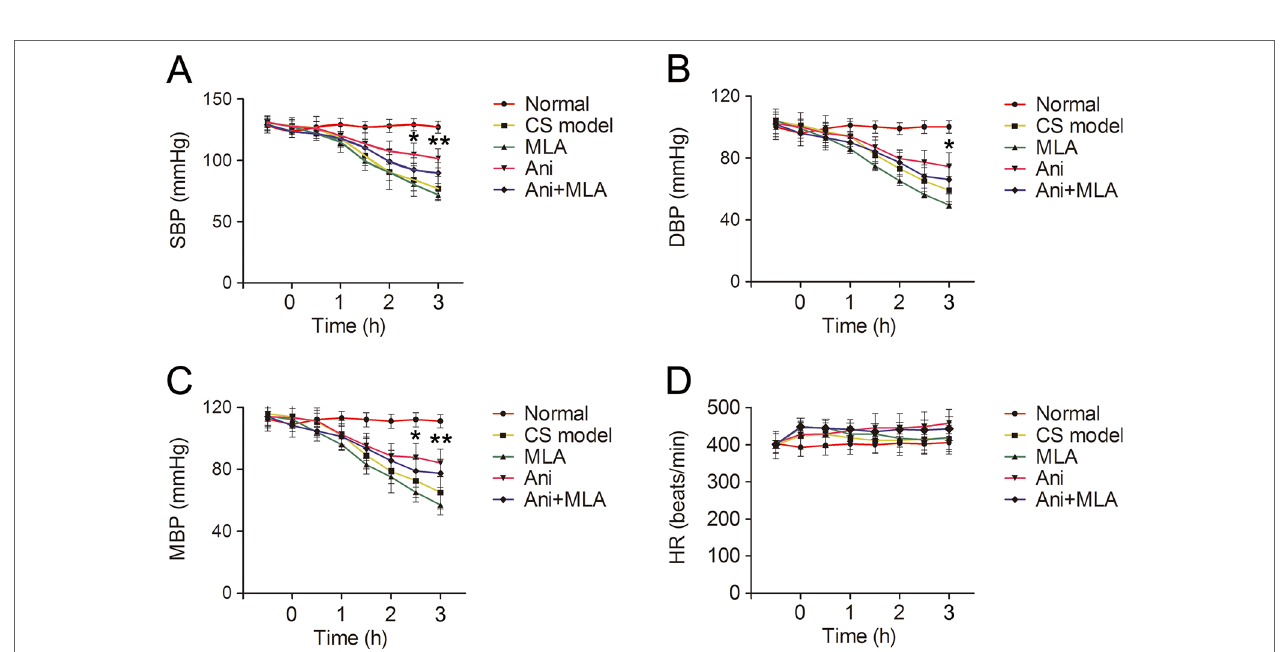
FIgURE 8 | Anisodamine (Ani) increases blood pressure in rats with crush syndrome (CS). Ani (20 mg/kg, i.p.) was administrated at 30 min before decompression in rats with CS, and methyllycaconitine (MLA) (7 mg/kg, i.p.) was given 30 min earlier. Blood pressure was monitored for 3.5 h since 30 min before decompression. Systolic blood pressure (SBP), diastolic blood pressure (DBP), mean blood pressure (MBP) decreased gradually after decompression in rats with CS. Ani significantly increased SBP and MBP at 2.5 h after decompression and increased SBP (A) , DBP (B) , and MBP (C) at 3 h after decompression. MLA attenuated the effect of Ani on blood pressure. Heart rate (HR) was not affected by compression, decompression, or drug administration (D) . N = 6 per group. * P < 0.05, ** P < 0.01 vs. CS model.